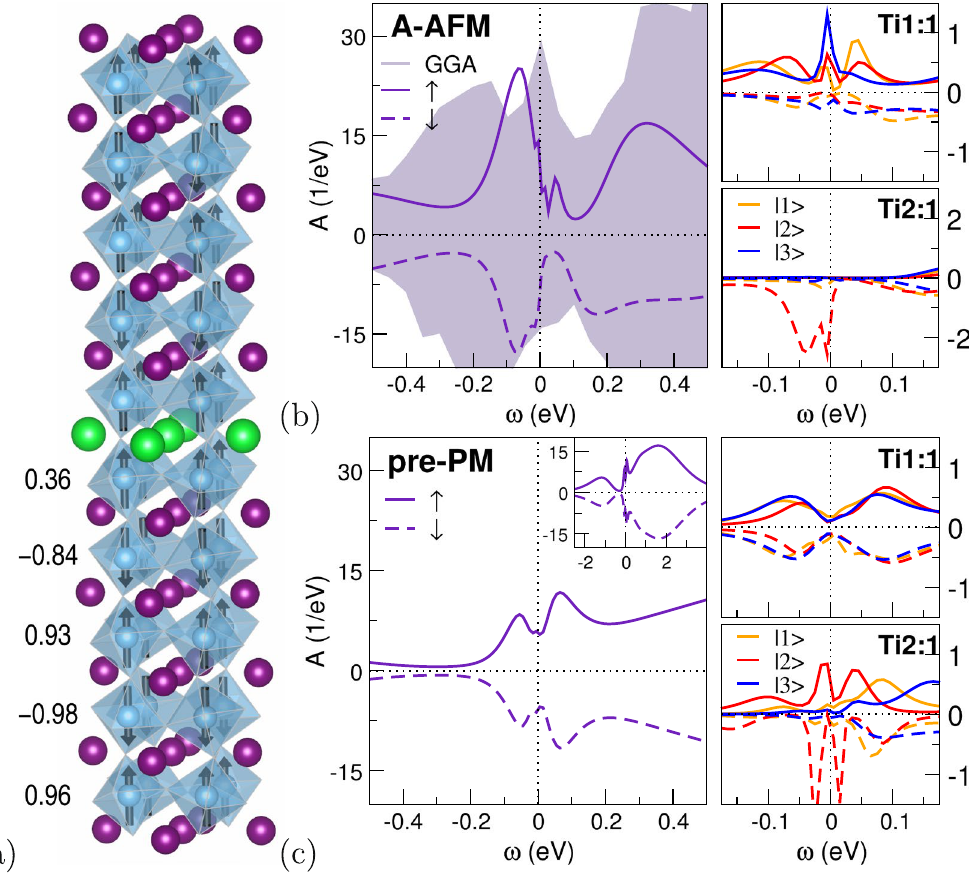
Figure 3. δ -doped SmTiO 3 with broken spin symmetry ( T = 48 K). ( a ) A-AFM magnetic order, numbers provide local Ti magnetic moment in μ B . ( b,c ) Spectral function, left: total, right: local Ti for first and second layer (not shown: similar data for Ti:2 sites). ( b ) A-type AFM phase. ( c ) Pre-converged phase (after 20 DFT + DMFT steps), when starting the self-consistent calculation from the PM